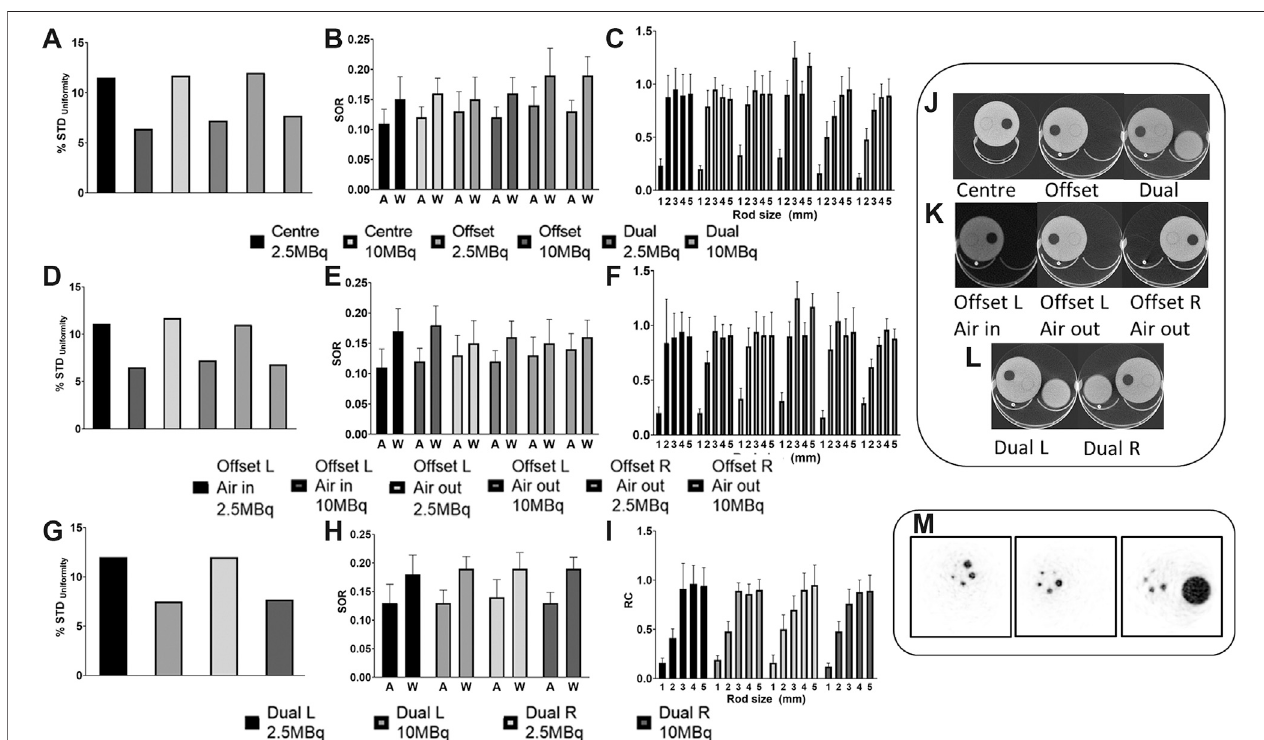
FIGURE 3 | Assessment of NEMA NU4 Image Quality for the single centered, single offset and dual phantom cases. (A – C) Uniformity, SOR and Recovery Coef fi cientsforthecentered,offsetanddualphantompositionsindicatedin (J) . (D – F) Uniformity,SORandRecoveryCoef fi cientsforthesingleleftorrightoffsetposition withtheairchamberfacingthecenteroredgeofthe fi eldofviewasindicatedin (K) . (G – I) Uniformity,SORandRecoveryCoef fi cientsforthedualphantomcon fi guration, with the NEMA IQ phantom in the left or right position as indicated in (L) . (M) Variable orientation of rods in NEMA NU4 phantom. Error bars: standard deviation.